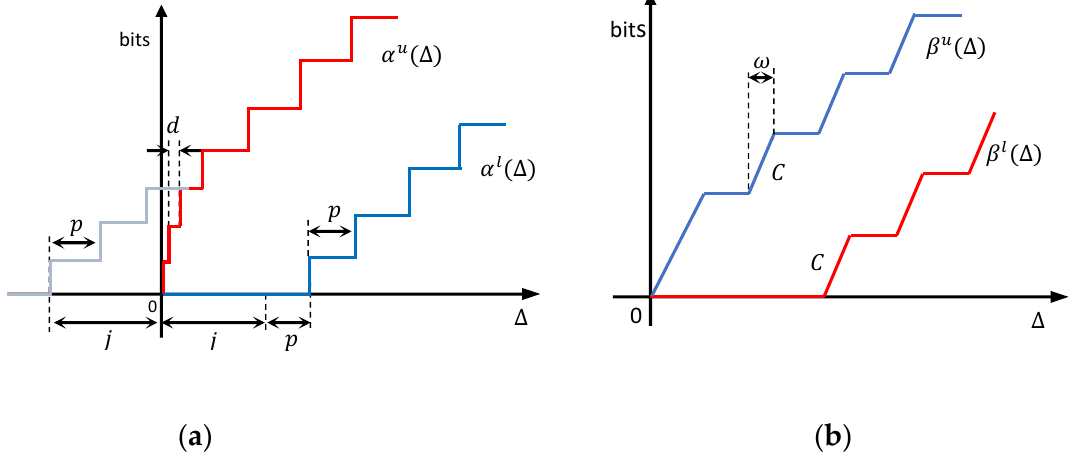
Figure 5. Examples of upper and lower bounds: ( a ) the arrival curve and ( b ) the service curve for a periodic time division multiple access (TDMA) system.